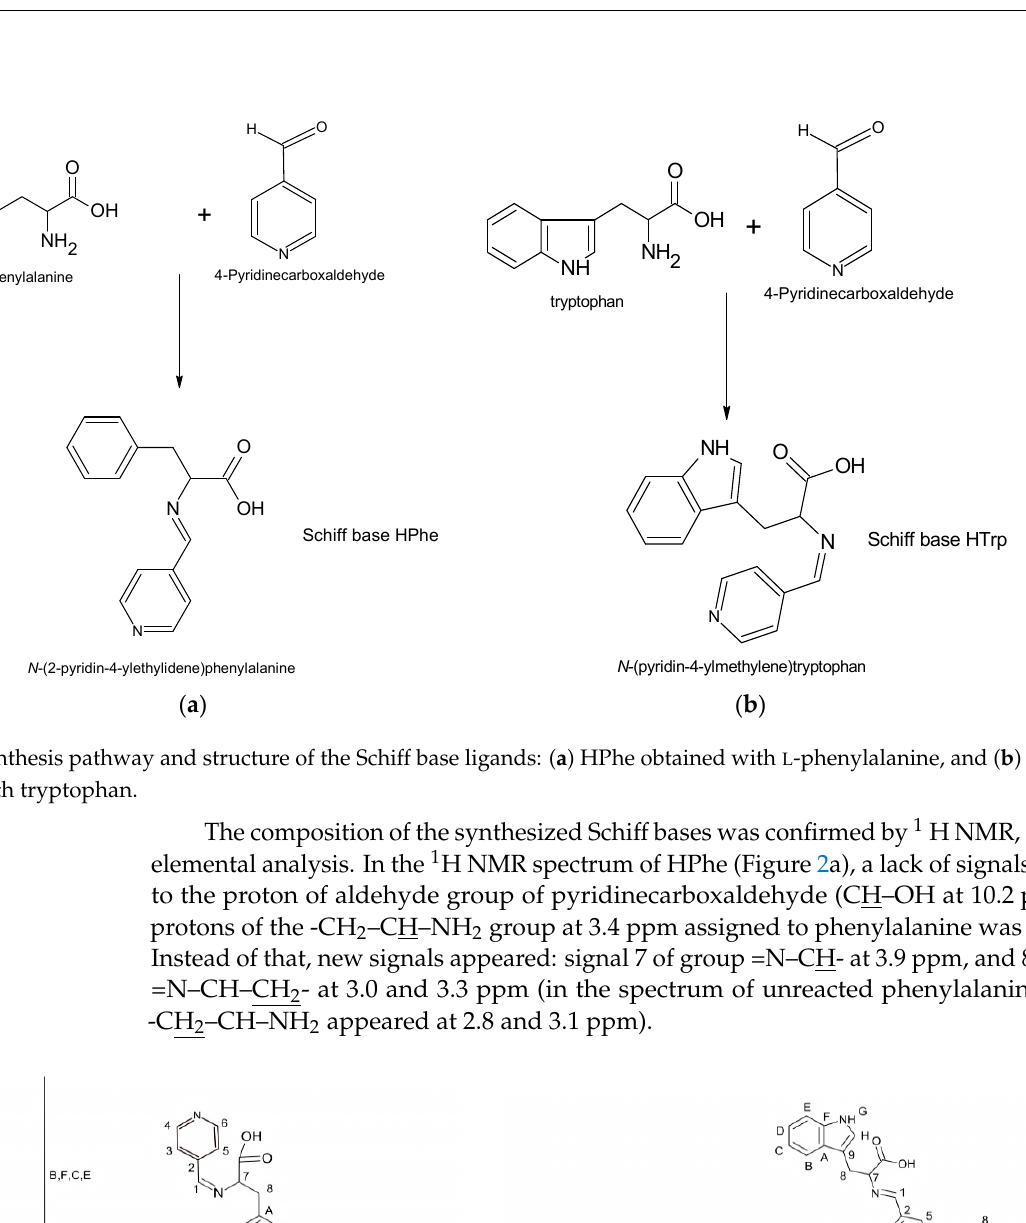
Figure 2. 1 H NMR spectra (in DMSO d 6 ) of the Schiff base; HPhe obtained with L -phenylalanine ( a ), and HTrp obtained with tryptophan ( b ).